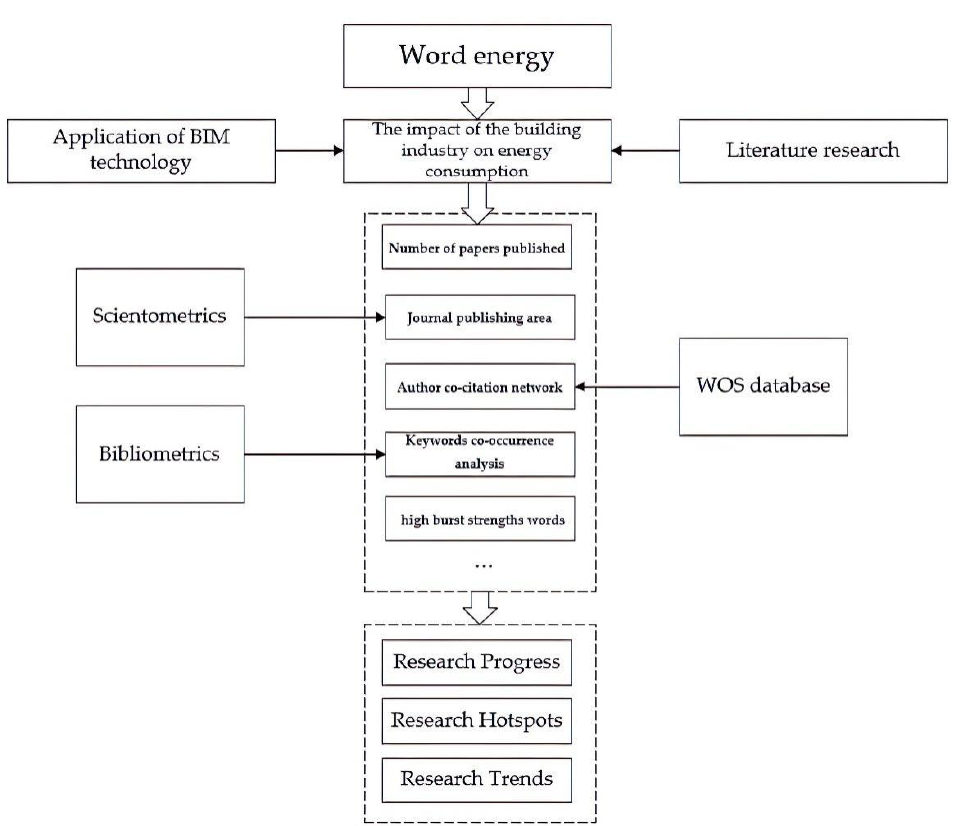
Figure 1. Research methodology.